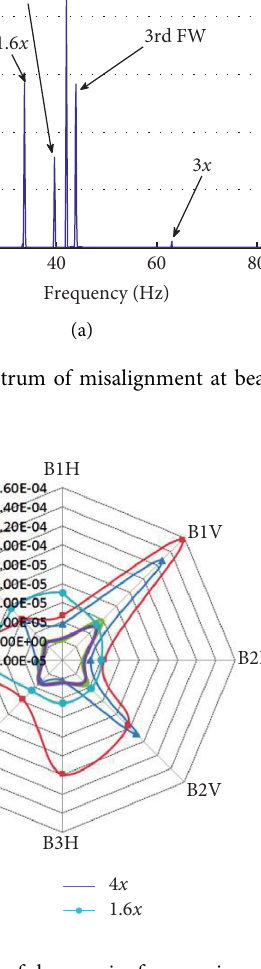
Figure 13: Radar chart of harmonic frequencies at the four